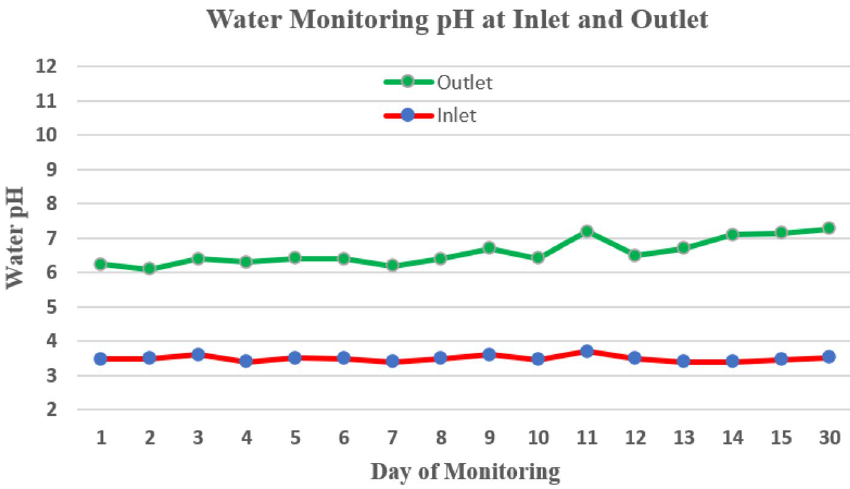
Figure 5. Water pH monitoring at inlet and outlet during experimental on day 1 until day 30 of treatment.